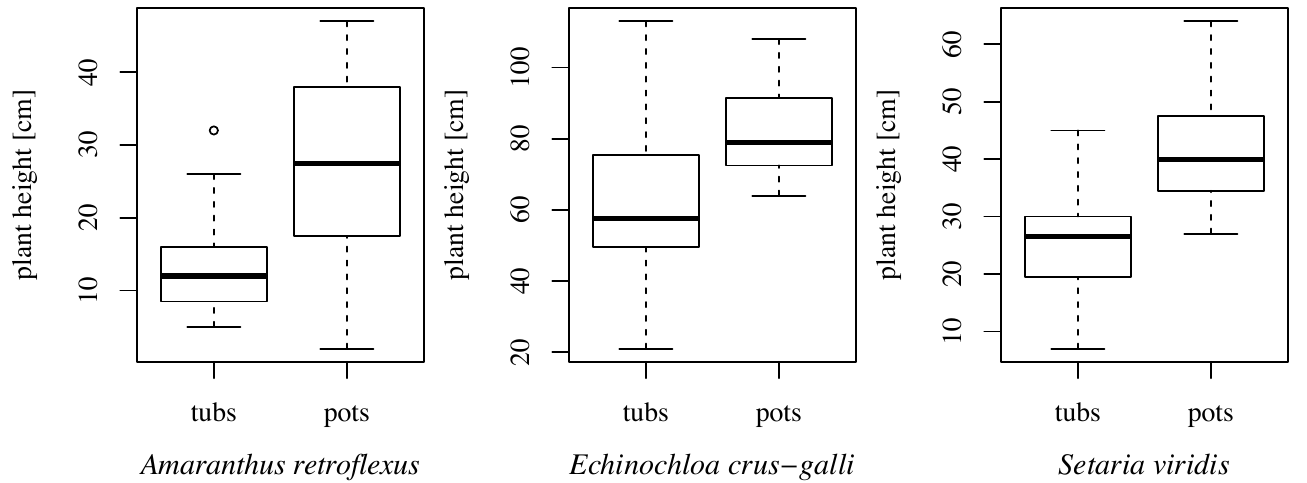
Fig. 4: Comparison of the plant height of weeds grown in pots and tubs at the end of mid-growth phase for both climate chambers for the three replica- tions.